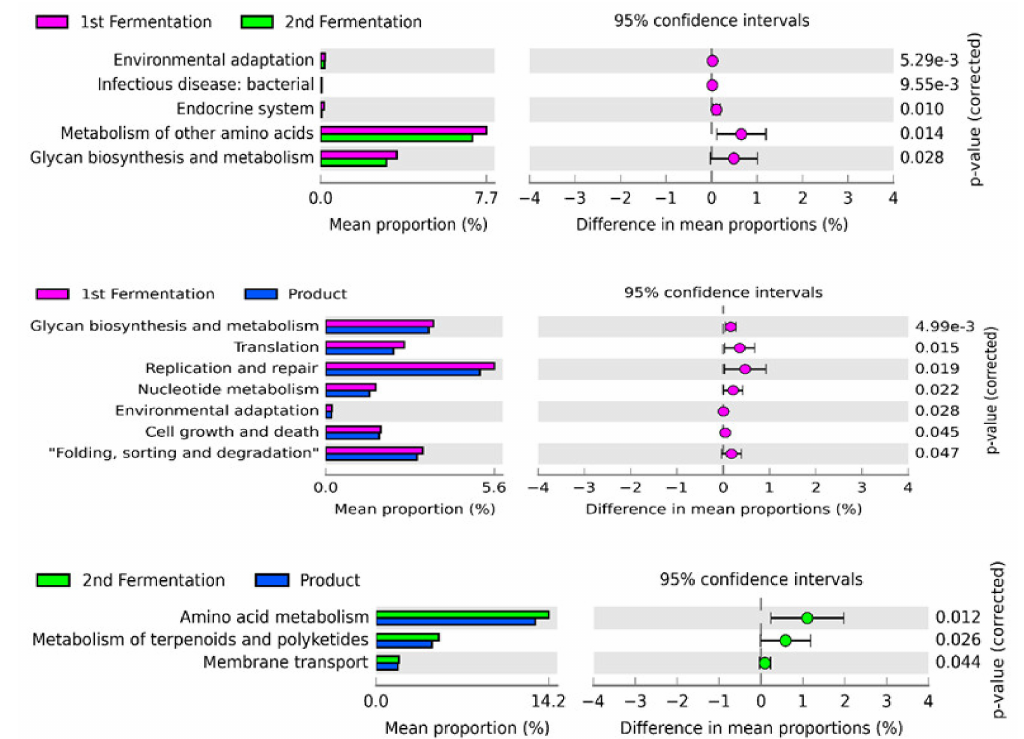
Figure 5. Enriched predicted functions across the fermentation stages and product. The left panel of these figures shows the abundance of differentially predicted functions. The right panel represents the significant difference at p < 0.05. The middle panel indicates the mean proportion of differentially predicted functions at a 95% confidence